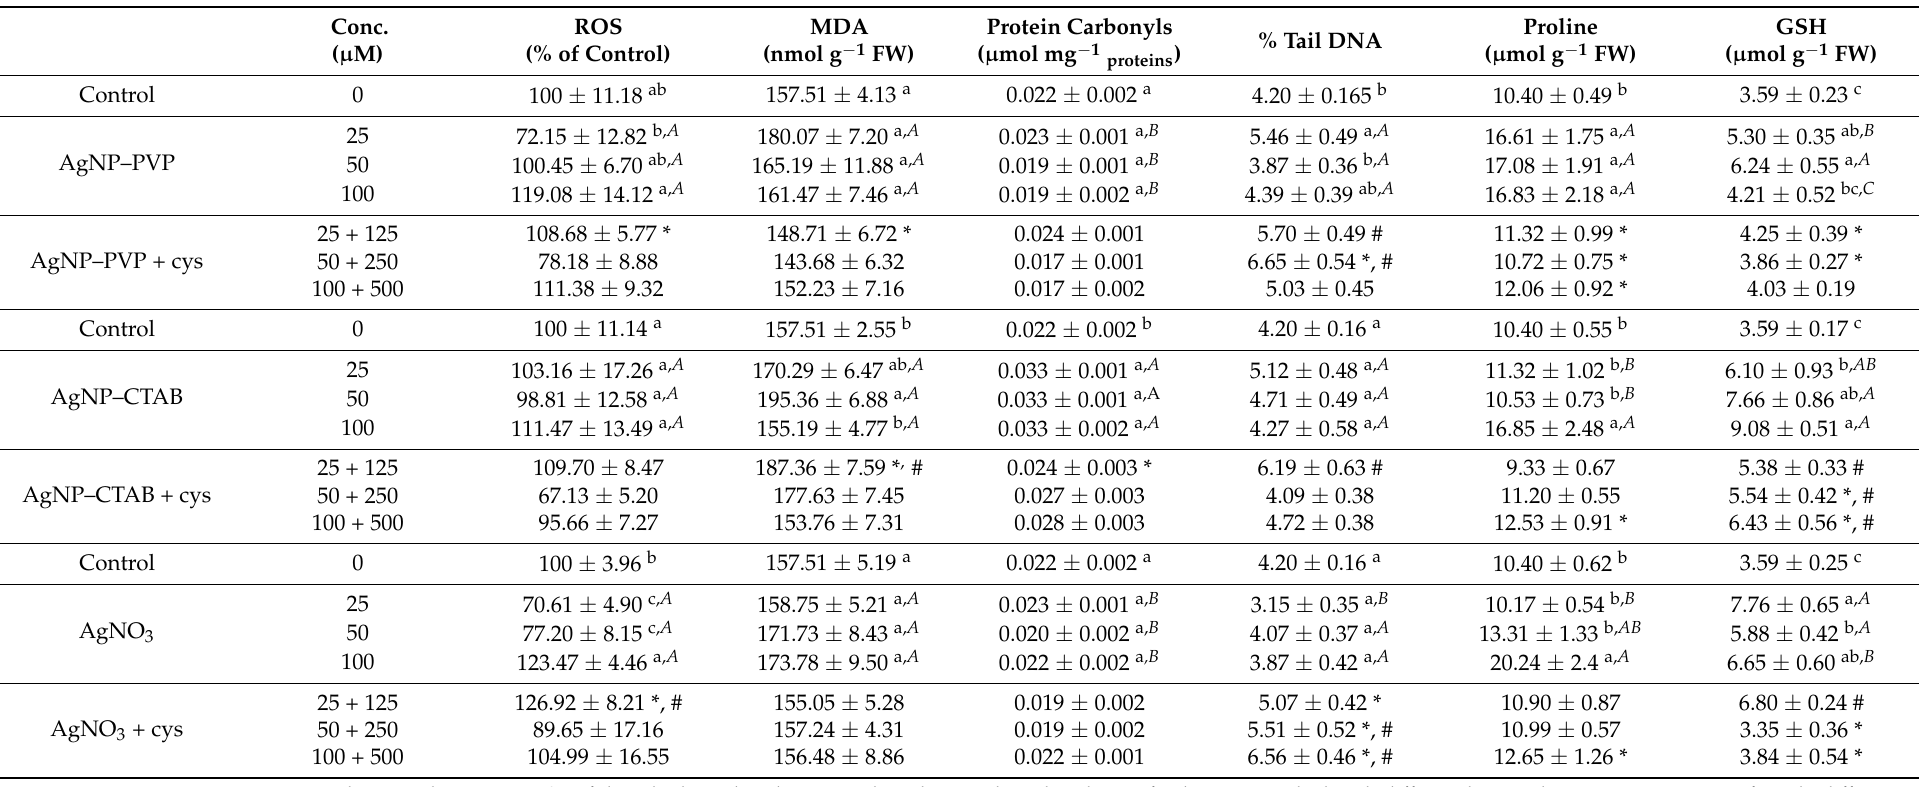
Table 3. Contents of reactive oxygen species (ROS), malondialdehyde (MDA), protein carbonyls, proline, reduced glutathione (GSH), and % tail DNA in leaves